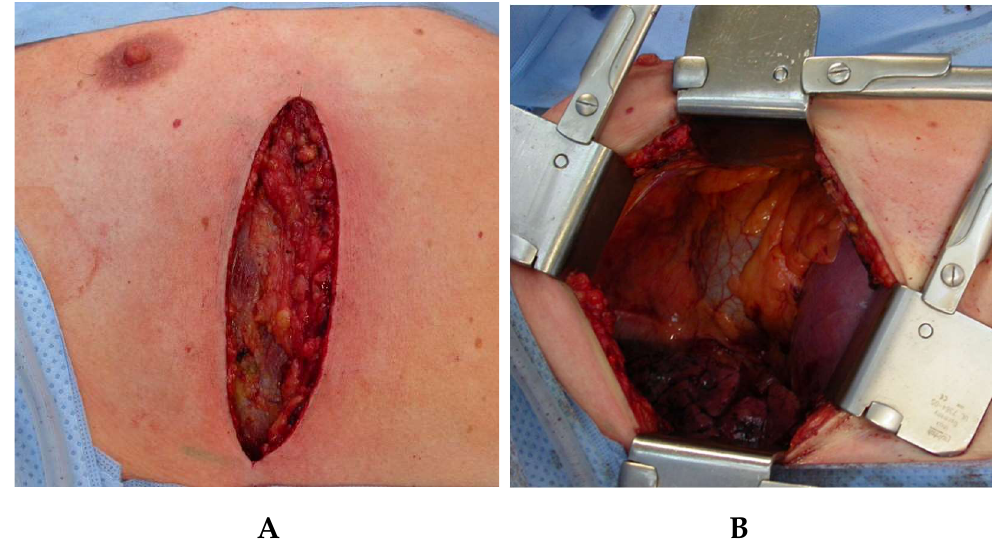
Figure 4. Muscle-sparing right lateral thoracotomy at fifth intercostal space. A . Positioning and extend of the incision. B . Exposition after introduction of the surgical rip retractor.